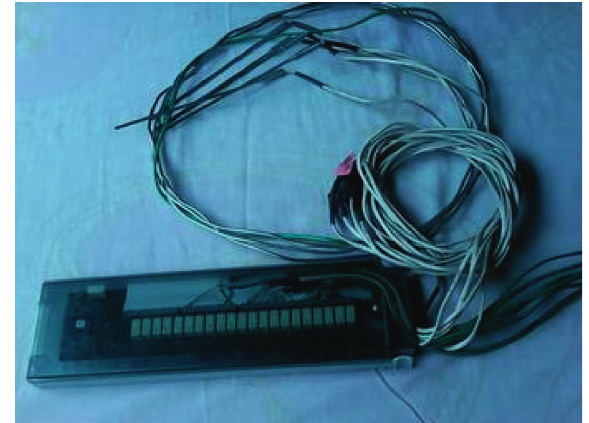
Figure 5: Array of 12 thermocouples connected to the 40-channel